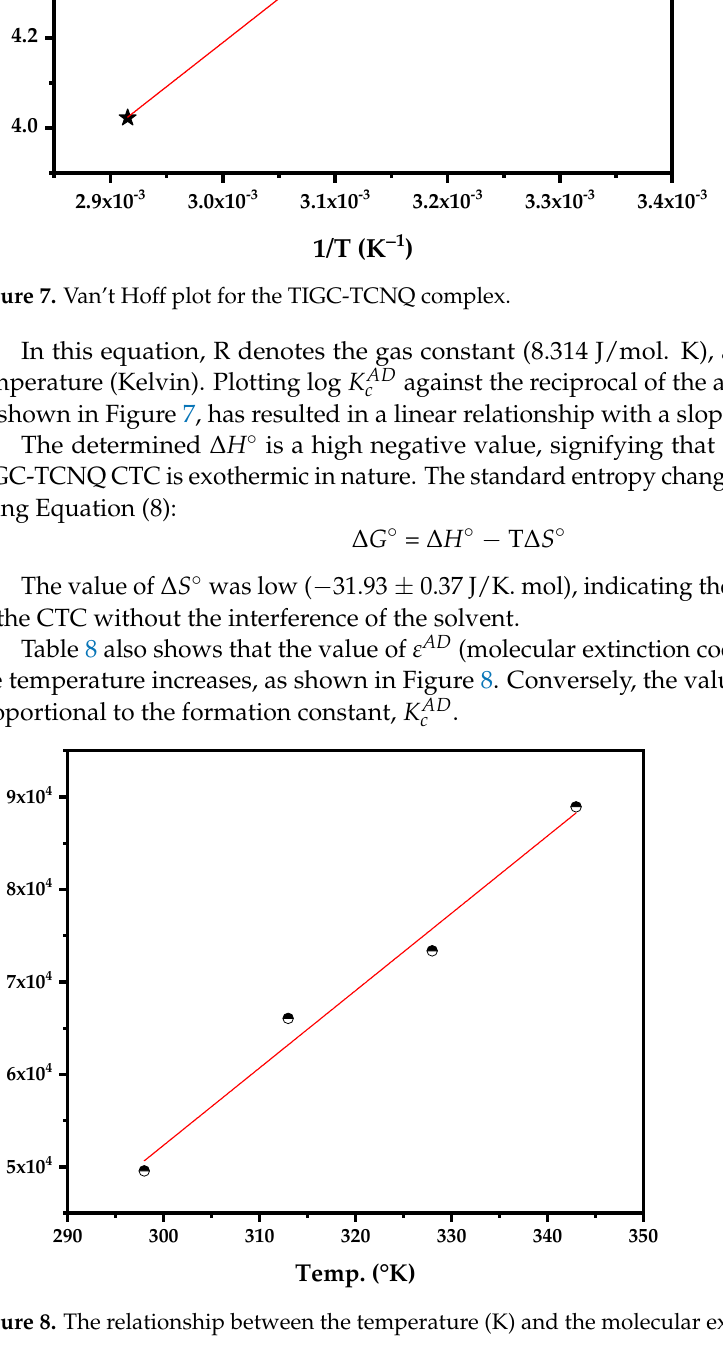
Figure 8. The relationship between the temperature (K) and the molecular extinction coefficient ( ε ).